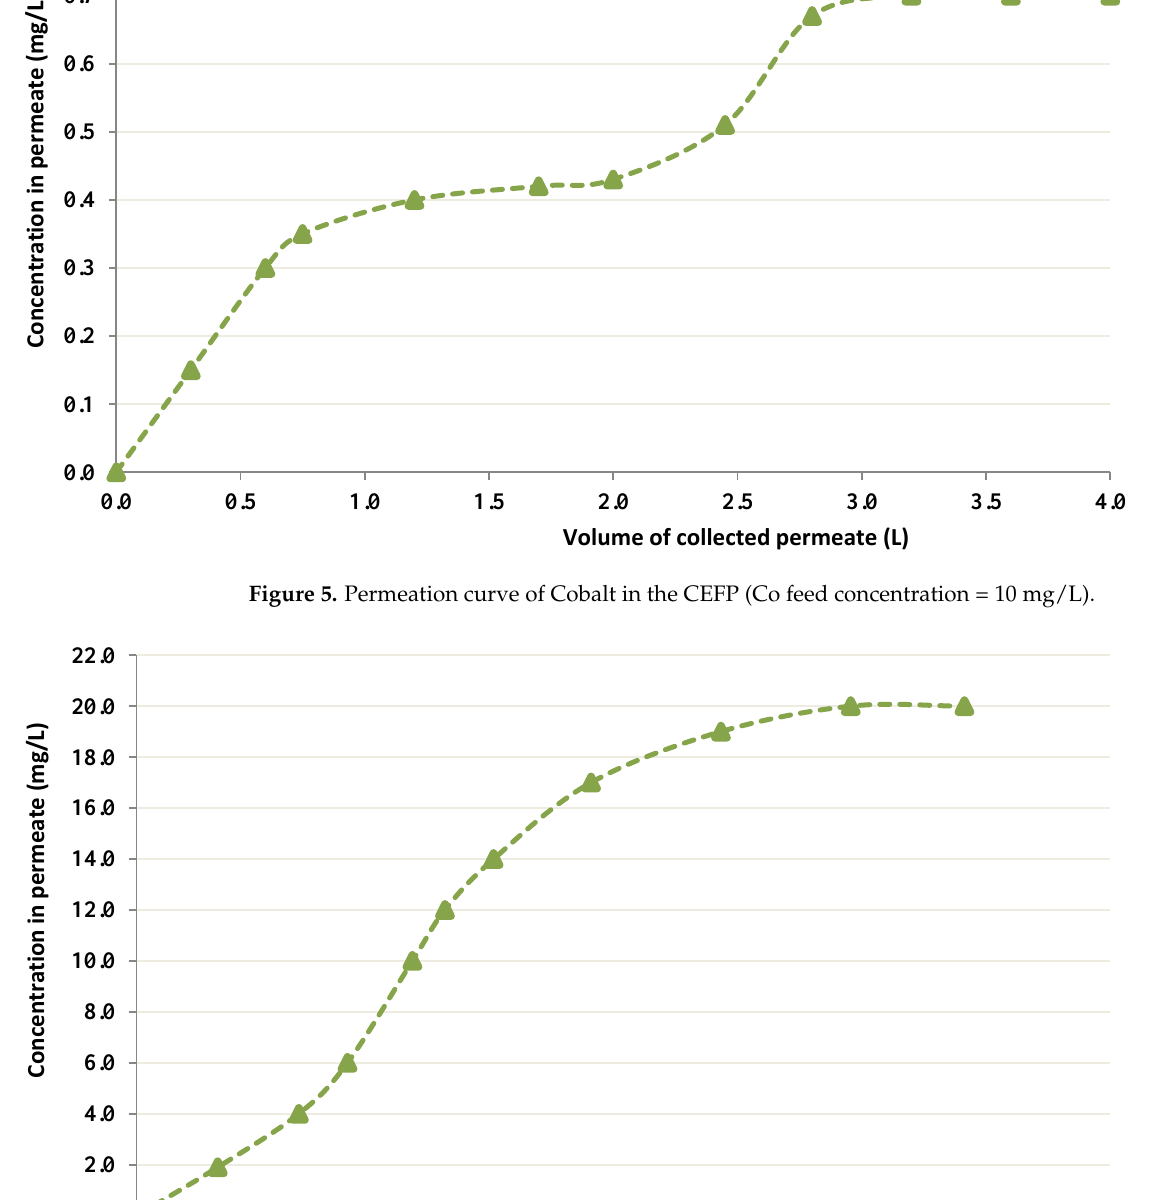
Figure 6. Permeation curve without chitin and with the Co feed solution (20 mg/L).